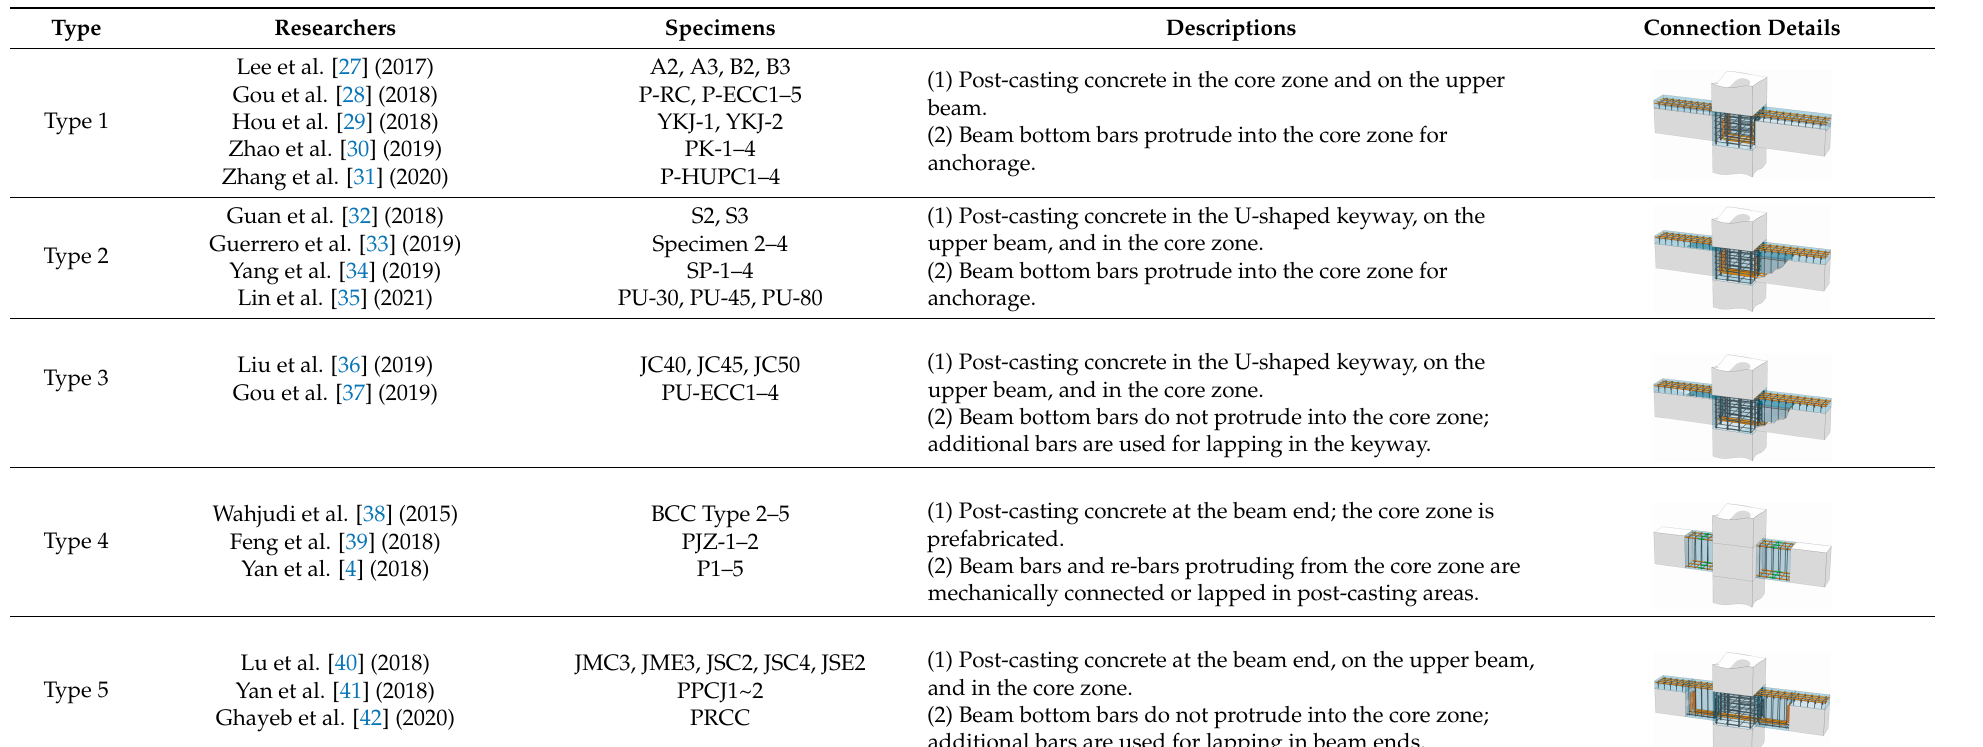
Table 1. Information of selected